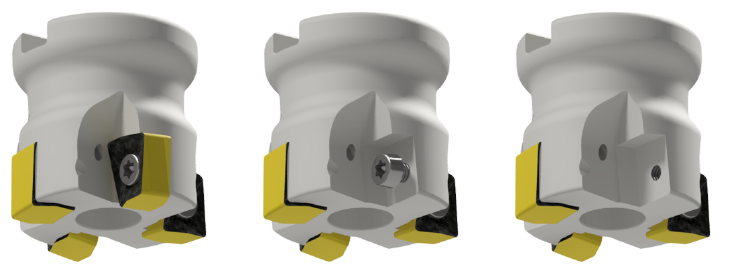
Figure 3. The tool H490 F90AX D040-4-16-12 in fault-free state- Class 0 ( left ), without the insert Class 1 ( middle ) and without the insert and without the screw Class 2 ( right